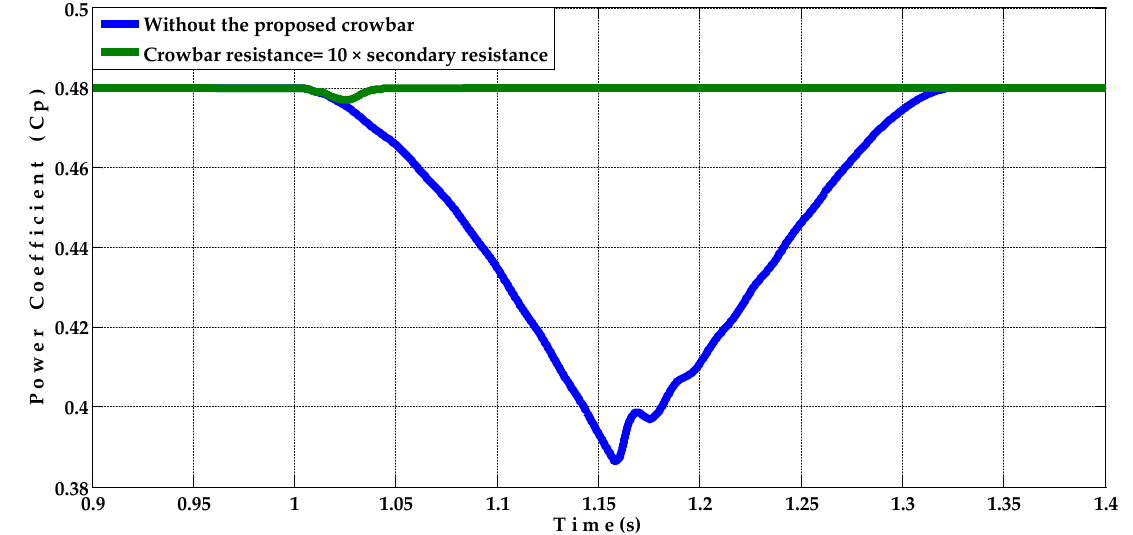
Figure 9. Power coefficient of wind turbine with and without the proposed crowbar under symmetrical fault occurrence.